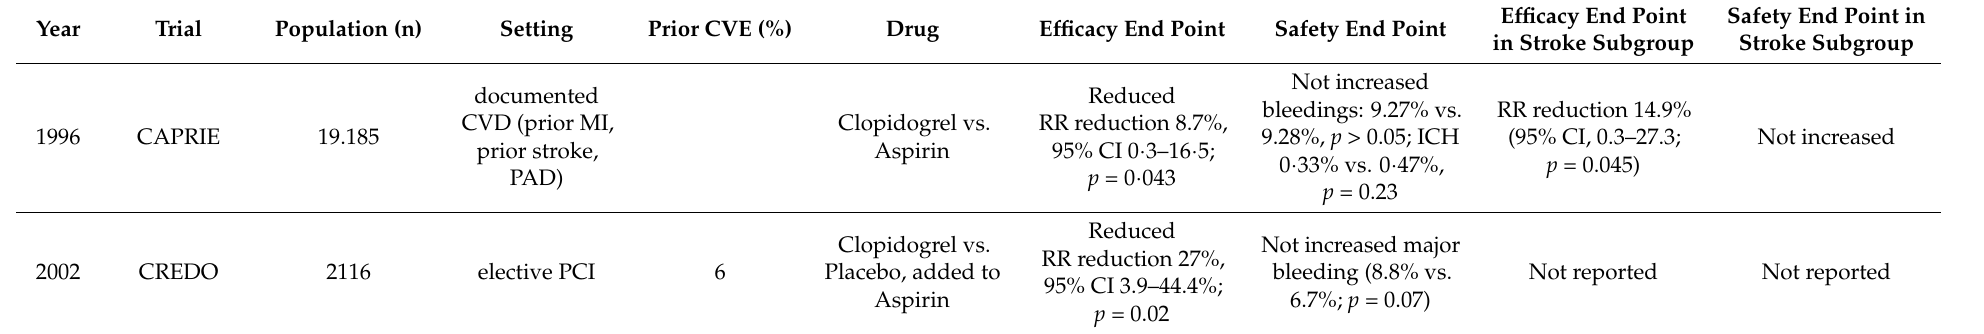
Table 2. Major trials on antithrombotic therapies in secondary